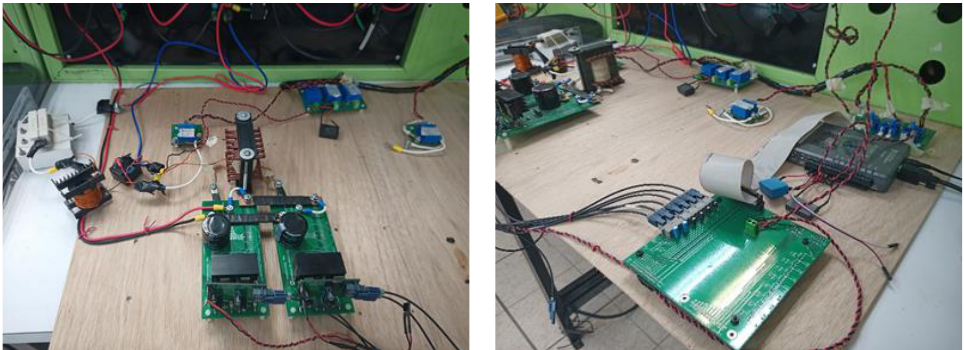
Figure 10. Prototype. Power (left) and control (right) stages.